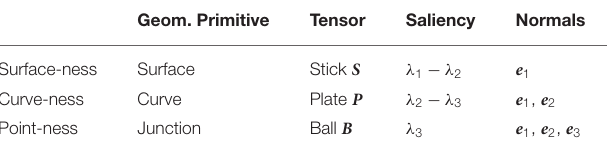
TABLE 1 | Interpretation of saliencies and preferred directions obtained by the tensor voting framework, where the λ d are the eigenvalues associated to the eigenvectors e d obtained from spectral decomposition of the resulting tensors. Predominating saliency determines the affected geometric primitive. Geom.